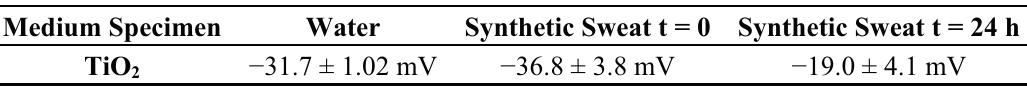
Table 1. Comparison of Z-potential values in water and in synthetic sweat (mean ±